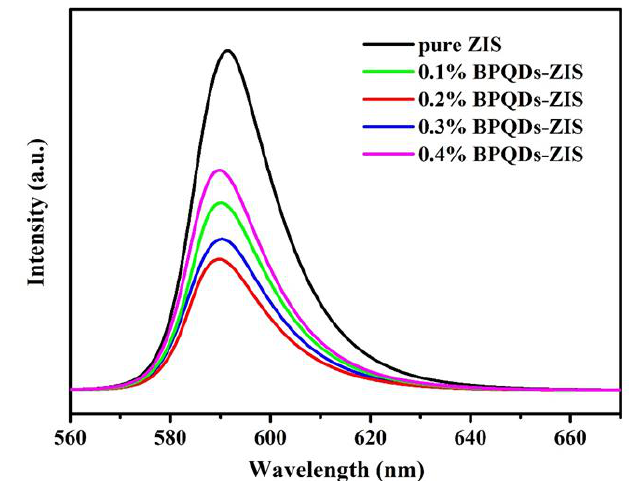
Figure 8. Photoluminescence (PL) spectra of pure ZnIn 2 S 4 and BPQD–ZIS hybrids.